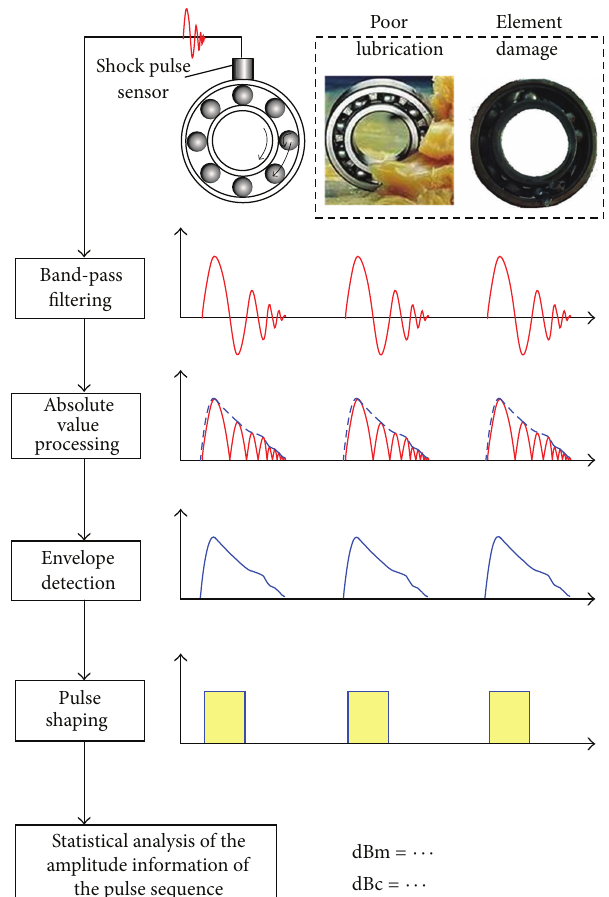
Figure 1: Block diagram of working principle of